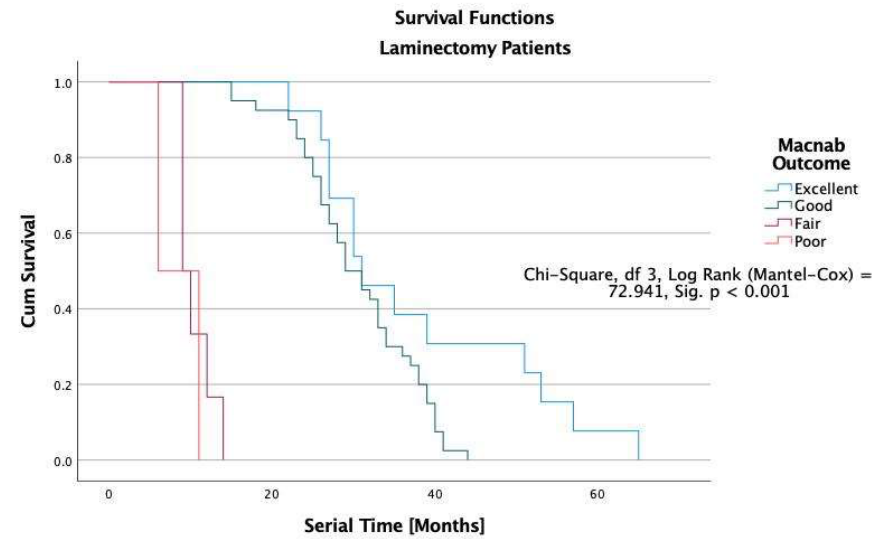
Figure 8. Kaplan-Meier (K-M) Survival functions by Macnab outcomes graphically illustrate the durability of TLIF surgery. Patients were censored if they required additional treatment after their index operation or if their outcome was not known at their final follow-up. The estimated median (50% percentile) overall durability (survival) among TLIF patients ( n = 78) was 36 months with a standard error of 2.752, a lower boundary of 30.607, and an upper boundary of 41.393 months. The survival time in TLIF patients with Excellent Macnab outcomes was 43 months with a standard error of 1.731, a lower boundary of 39.608, and an upper boundary of 46.392 months (Table